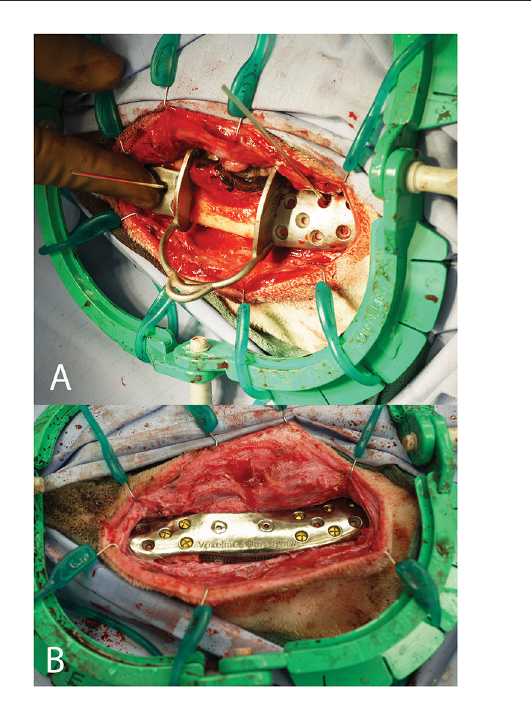
FIGURE15 Intra-operative photograph of the patient-specific surgical saw guide held in place with Kirshner wires (A) and of the patient-specific implant in place (B) . wires and the patient-specific mandibular reconstruction plate with the lattice graft basket secured, was placed using the corresponding holes. The plate was secured to the rostral and caudal mandible segments with pre-measured titanium cortical screws (Synthes, Paoli, PA) (Figure 15B). Finally, the bone graft was packed into the titanium lattice on the lingual aspect and the surgical site was closed in 3 layers. The patient recovered from anesthesia uneventfully and returned home the following day. No complications were noted at the time of follow-up at 2 weeks. At 1-year post-op, mucosal erosion over the implant was noted and a debridement and closure procedure were performed. Two months later, due to concern of infection, surgical debridement was performed, and the patient-specific implant was replaced with a 2.4